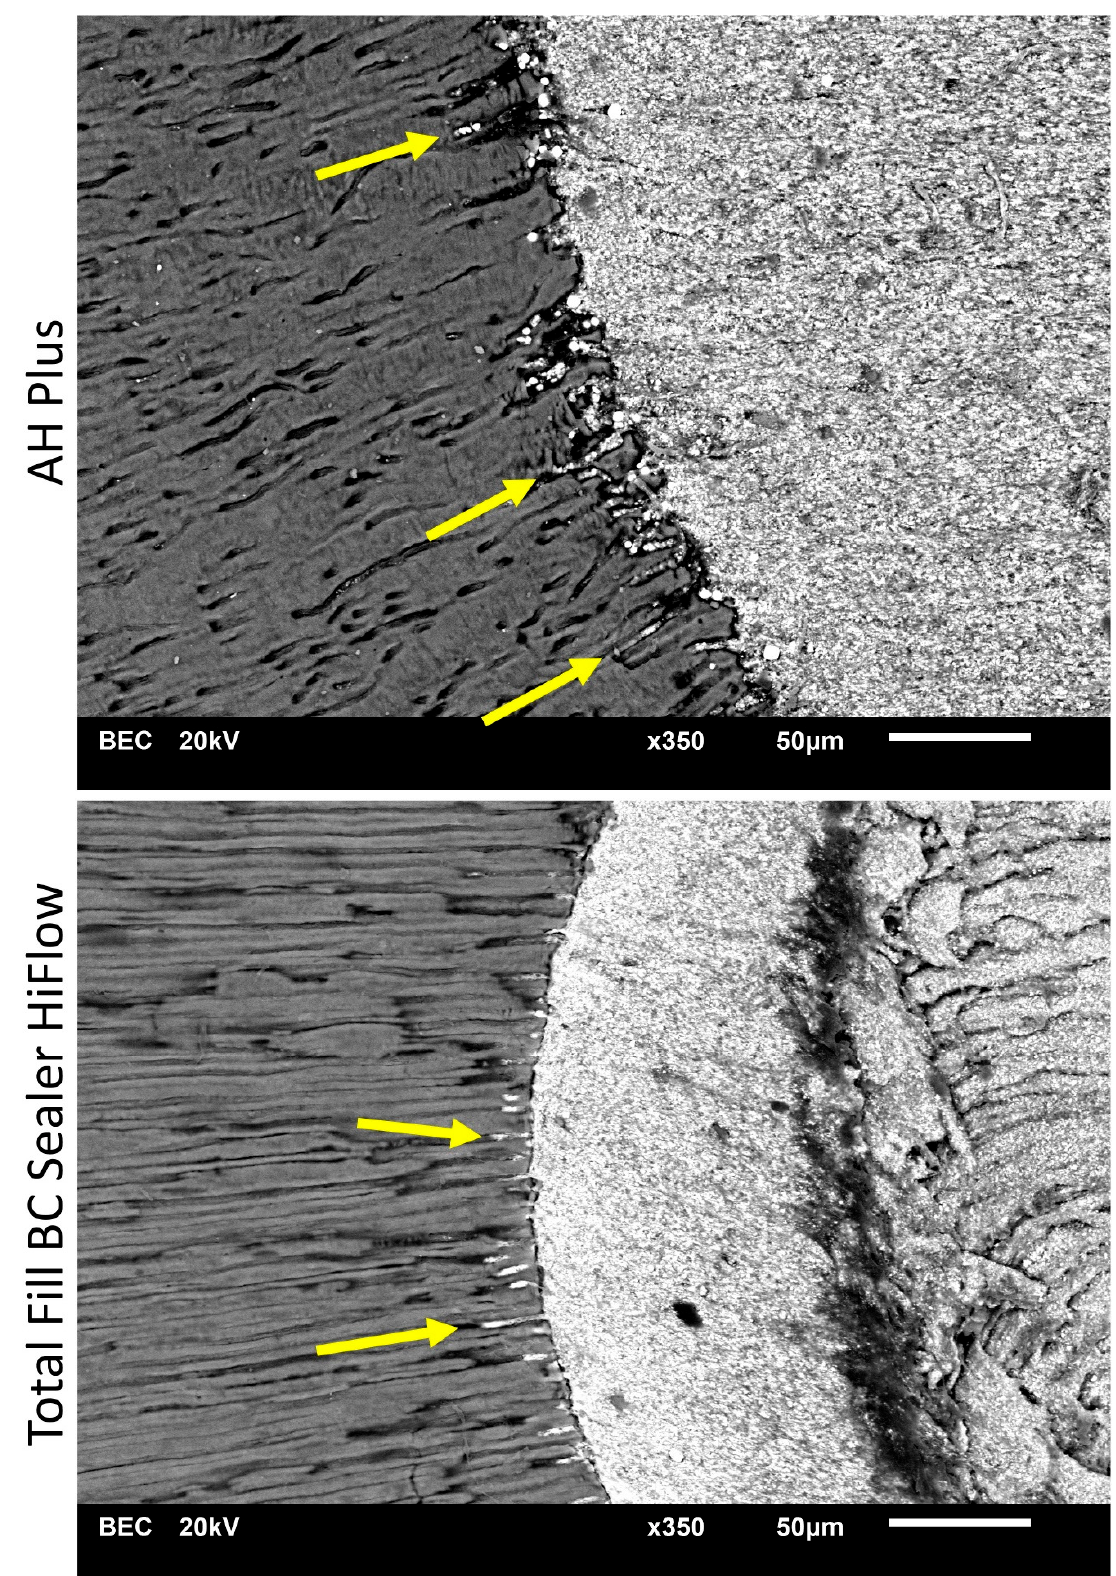
Figure 3. Scanning electron microscope (SEM) images display sealer penetration depth of AH Plus and Total Fill BC Sealer HiFlow after warm vertical root canal obturation at 8 mm from the root apex. Arrows indicating the sealer penetration depth found in SEM images.